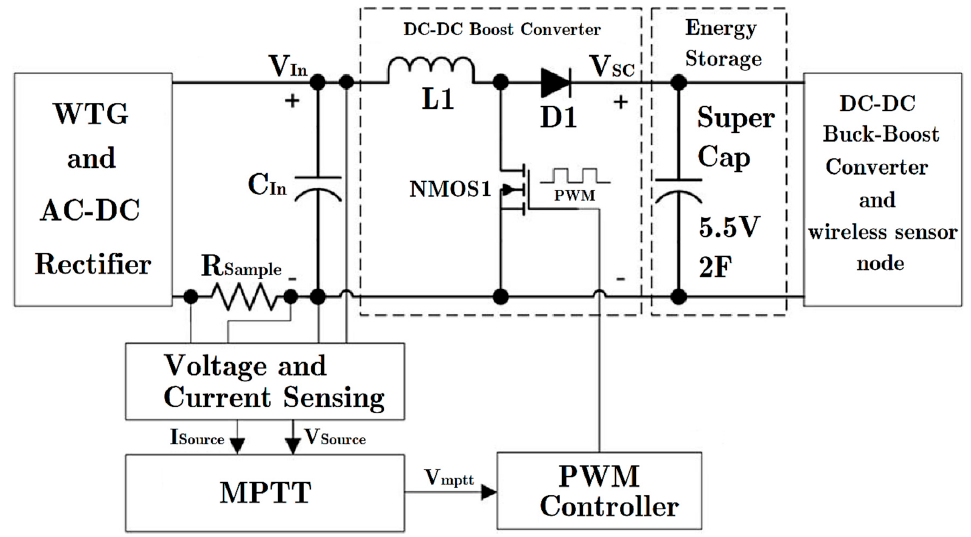
Figure 2. Overview of DC-DC Boost converter with Maximal Power Transferring Tracking (MPTT).